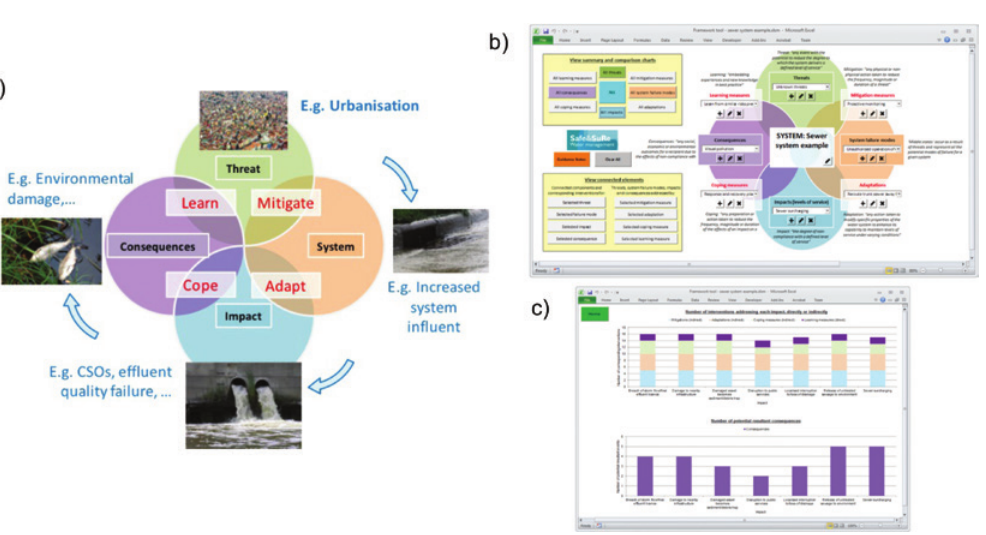
figure 4: (a) The safe & suRe interventions framework applied to the threat of increasing urbanization; (b) home page of the safe & suRe decision support tool; with (c) an illustration of the analysis